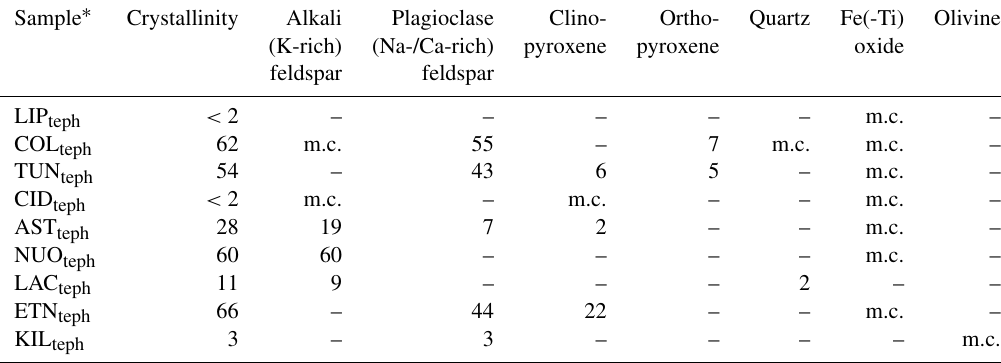
Table 2. Crystallinity and mineralogy of the tephra samples used in this study, in wt%. Sample